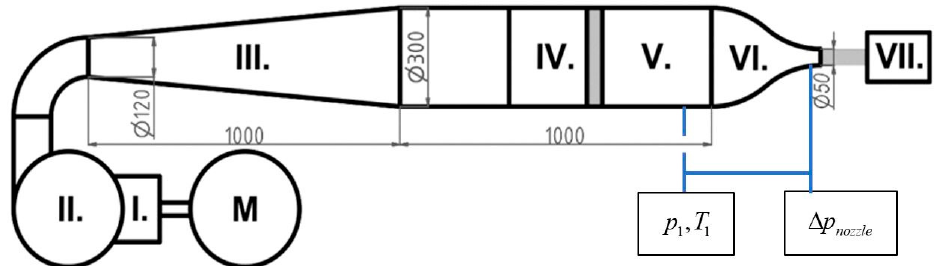
Figure 1. Scheme of the used high-speed track: M, electric motor; I., silencer in the compressor suction; II., radial turbocompressor; III., diffuser; IV., bleed valve; V., plenum chamber with static pressure and total temperature measurement; VI., nozzle; VII., test section.